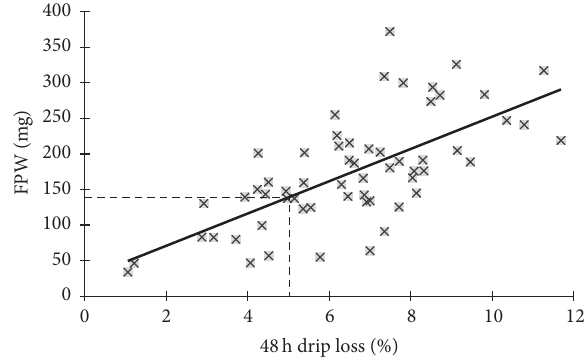
Figure 1: Linear regression of filter-paper wetness (FPW) as a function of 48 h drip loss by the bag method (DL) in pork loins ( 𝑛 = 60 ). Fluid weight (FPW), mg = 26.06 + 22.69 × DL ± 57.1 mg (SE), 𝑅 2 = 0.46, and 𝑃 < 0.0001